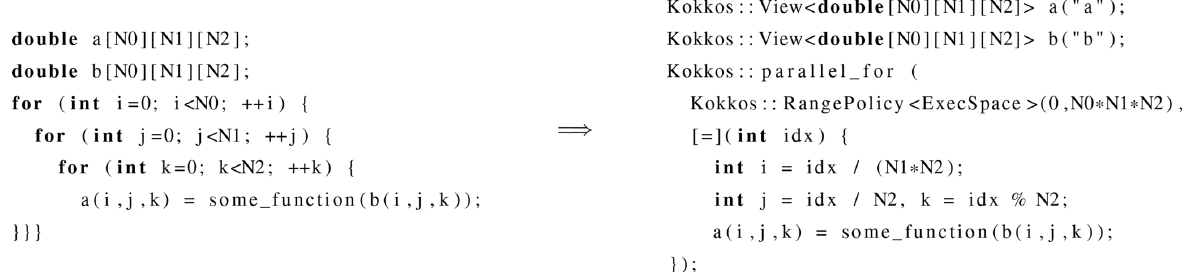
Figure 5. Parallelization of tightly nested loops via flattening and range policy. After flattening, modular arithmetic is used by each thread to determine the portion of input and output arrays to operate on.